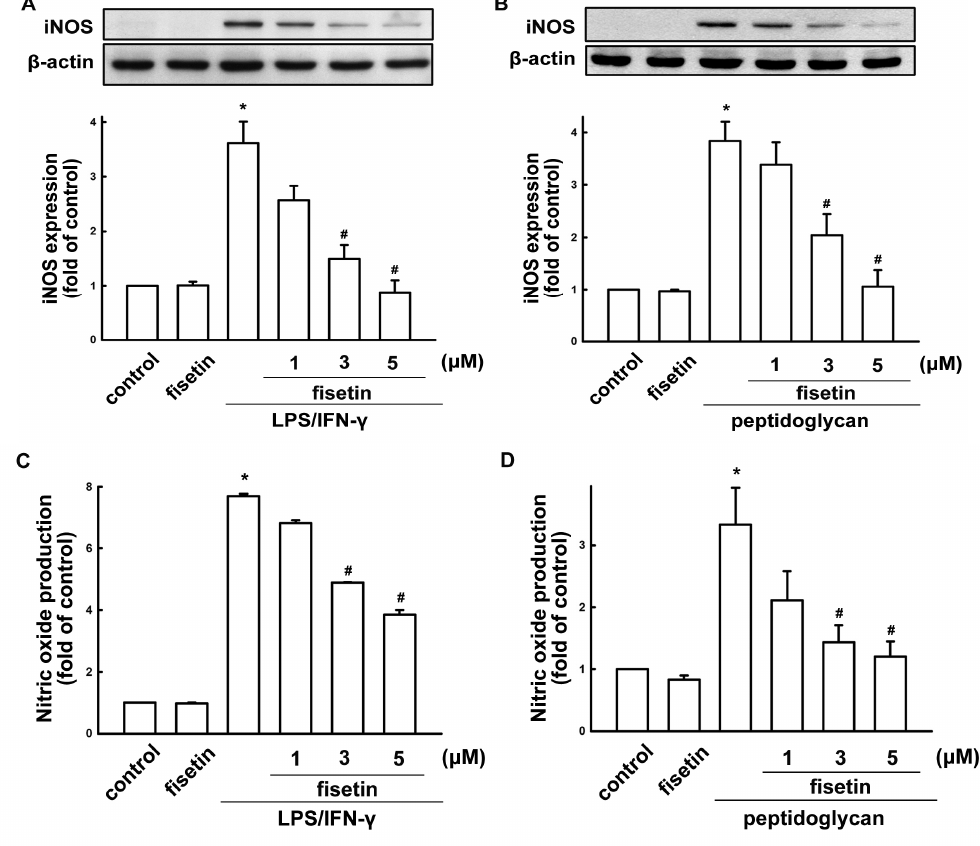
Figure 2. Inhibitory effect of fisetin on LPS/IFN- γ or peptidoglycan-stimulated iNOS/NO expression. ( A , C ) BV-2 microglial cells were pretreated with different concentrations of fisetin (1, 3, or 5 μ M) for 60 min before application of LPS (10 ng/mL) plus IFN-